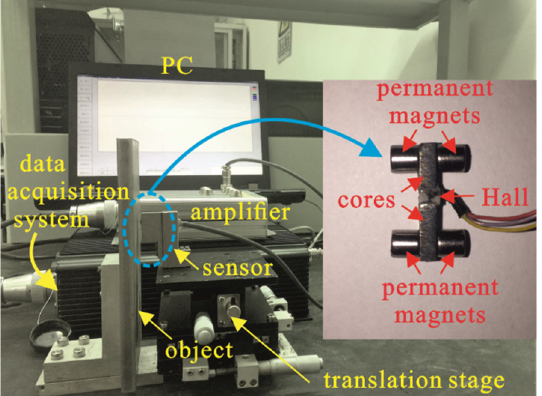
Table 3. Parameters of the PM-MFM sensor.